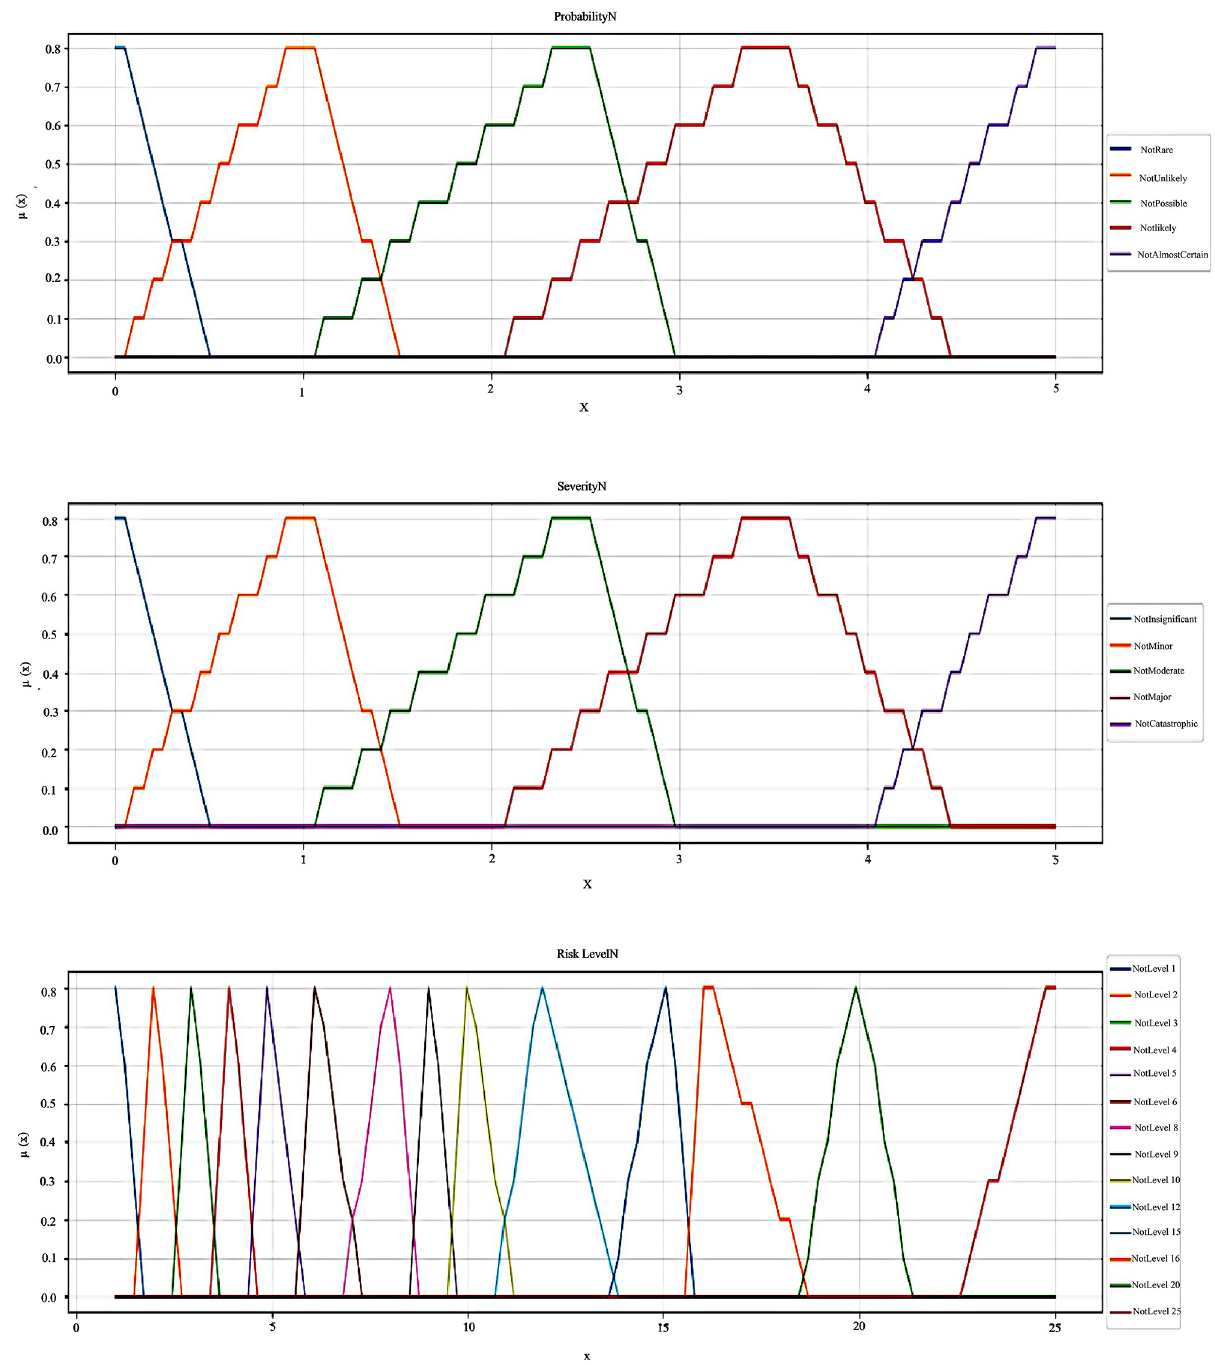
Fig 5. The non-membership curve plots of TIFNs for two input variables: Severity and probability and the output variable: Risk level.